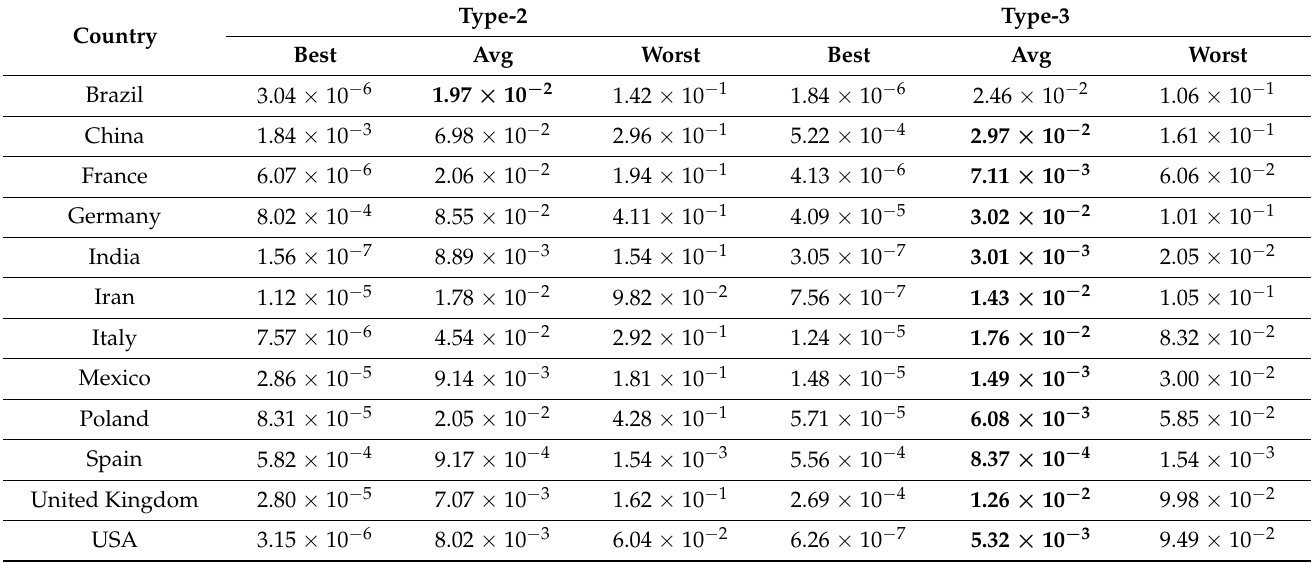
Table 13. First data period (future days).